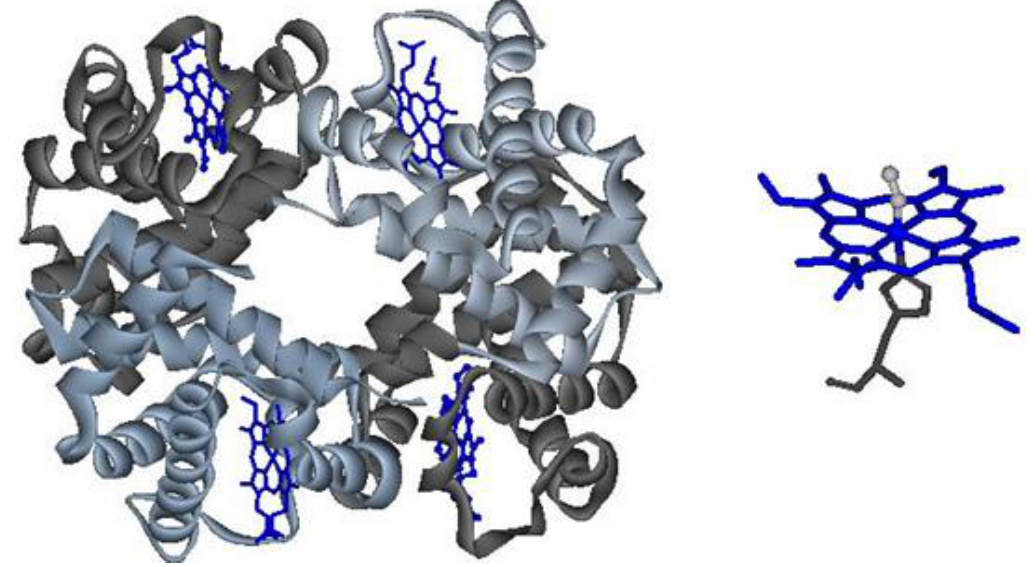
Figure 1. Left: quaternary structure of hemoglobin; right: heme, in its oxy